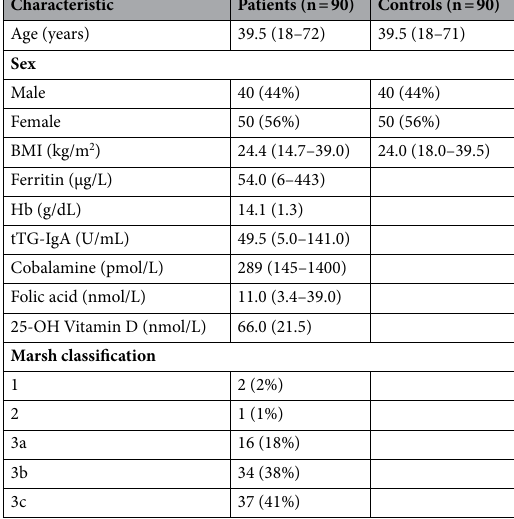
Table 1. Baseline characteristics in 90 patients with newly diagnosed celiac disease and 90 healthy control subjects. Data are displayed as number (%), median (range), except for Hb and 25-OH Vitamin D; mean (SD).